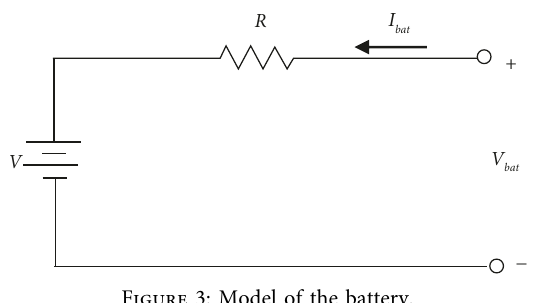
Figure 3: Model of the